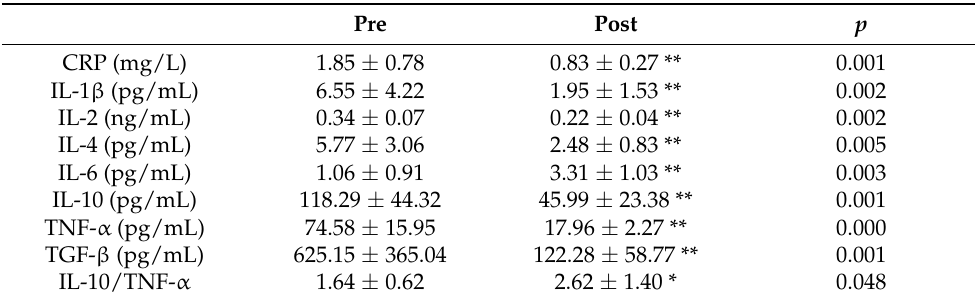
Table 2. Inflammatory markers pre- and post-sprint interval